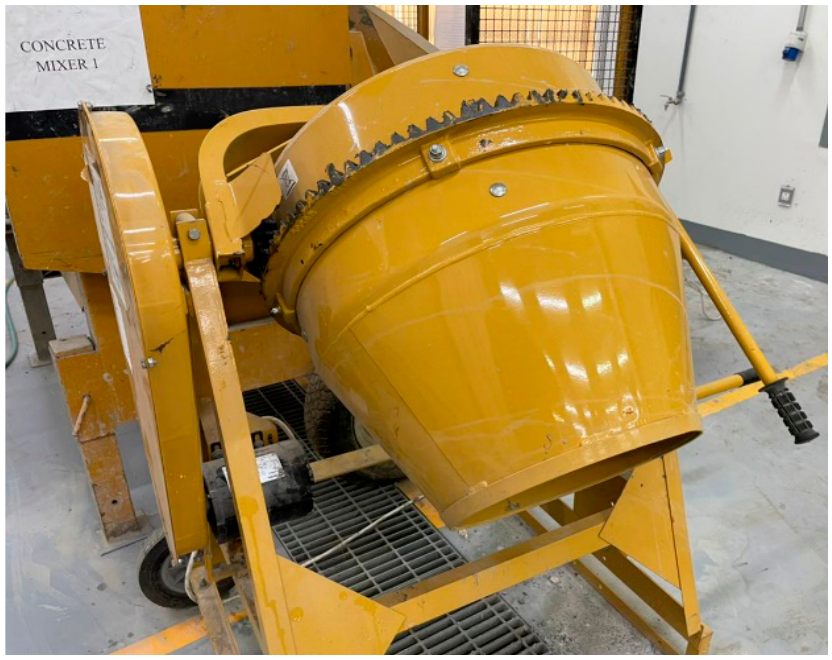
Figure 3. Drum Figure 3. Drum mixer.